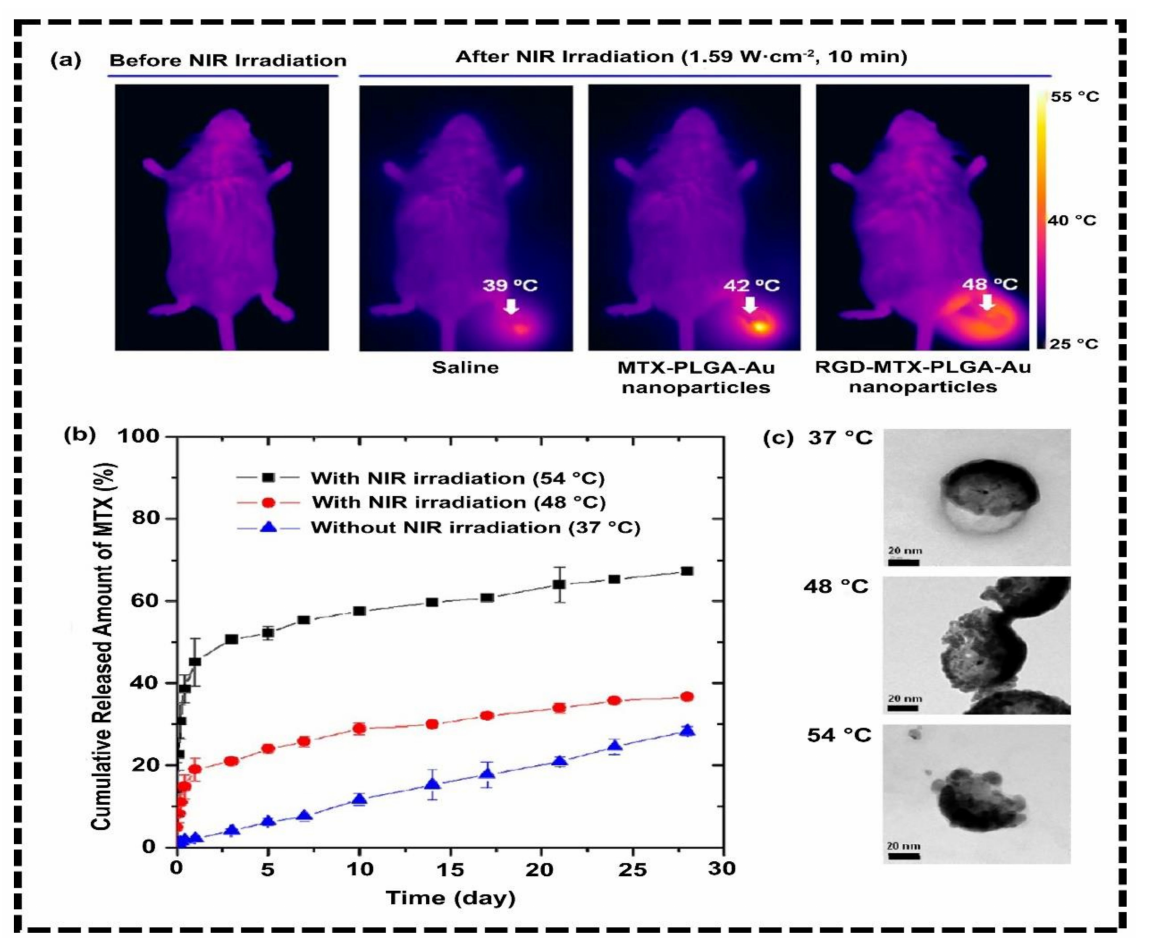
Figure 5. ( a ) Thermal images of different mice treated in different conditions; ( b ) MTX release profile with NIR, without NIR. ( c ) Transmission electron microscopy (TEM) images of MTX release experiments in different temperatures without and with NIR irradiation. Adapted with permission from Ref. [100]. 2013, American Chemical